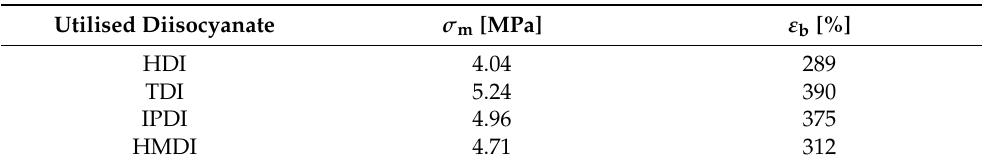
Table 2. Comparison of mechanical properties of BAMO-AMMO copolymers cross-linked with common diisocyanate agents investigated in